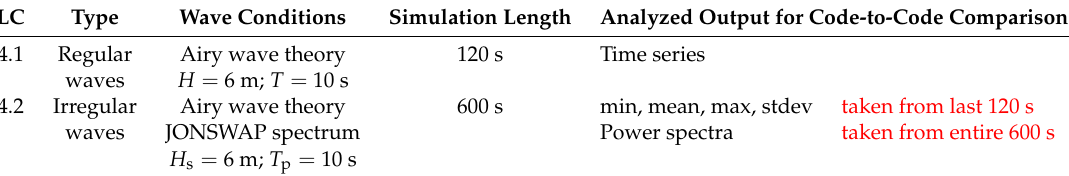
Table 7. Simulation settings and analysis methods for LC group 4.x, assumptions are written in